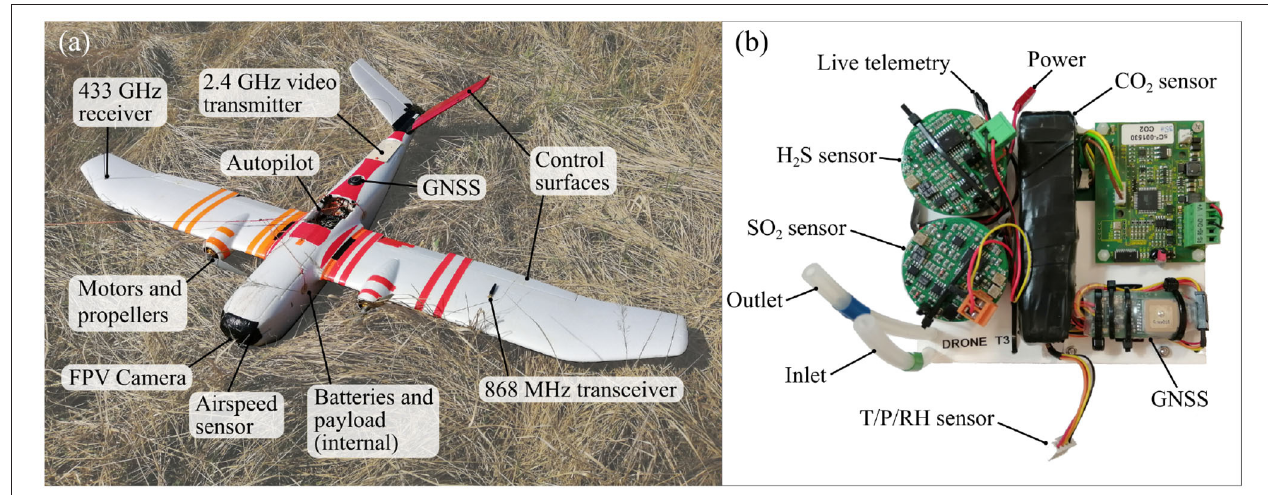
FIGURE 2 | (a) The “Titan” fixed-wing UAS. The radio frequency transmitters have been positioned as separated as possible to ensure clear transmissions without blocking from the fuselage or interference. (b) The multi-species gas sensor unit. The sensor was additionally shielded with metal foil (not shown) when installed in the fuselage to prevent interference from the vehicle RF